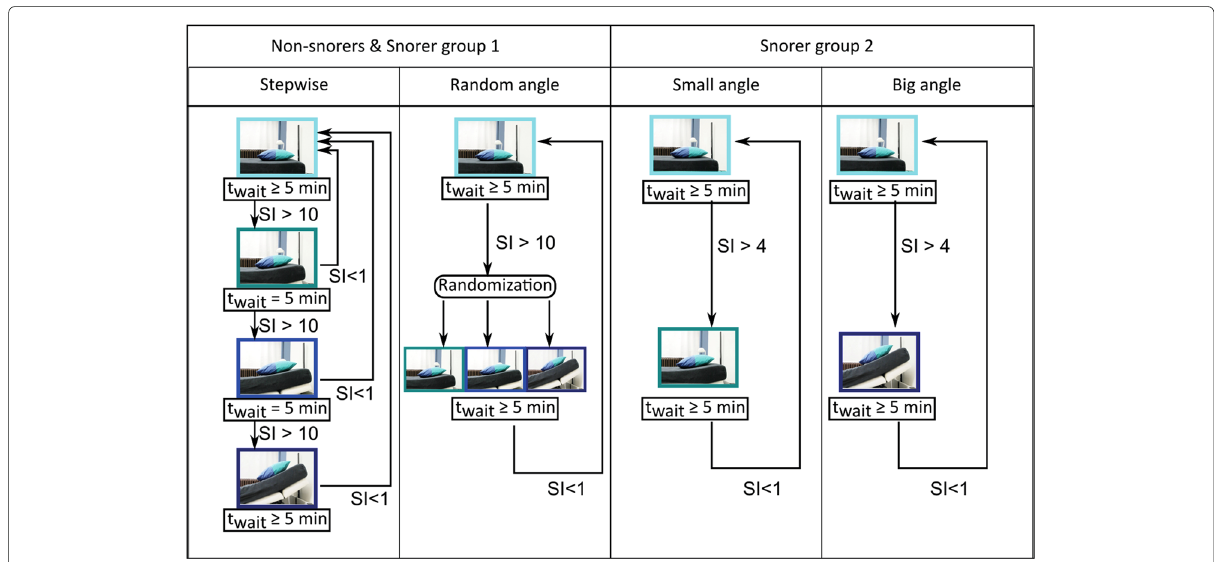
Fig. 2 Interventions provided by the bed. Participants of the groups snorerone and non-snorer were provided with a stepwise intervention and a randomangle intervention. During stepwise intervention, the bed was elevated upon the detection of snoring. If snoring stopped within 5 minutes, the bed went back to P0. Otherwise, the inclination was increased to the next step. During the randomangle intervention, the bed went to one of the three inclination angles upon detection of snoring and waited in this position until snoring stopped. The group snorertwo got two different interventions. During the smallangle intervention, the bed moved to P10 upon detection of snoring and back to neutral when snoring stopped. During the bigangle intervention, the bed went to P20